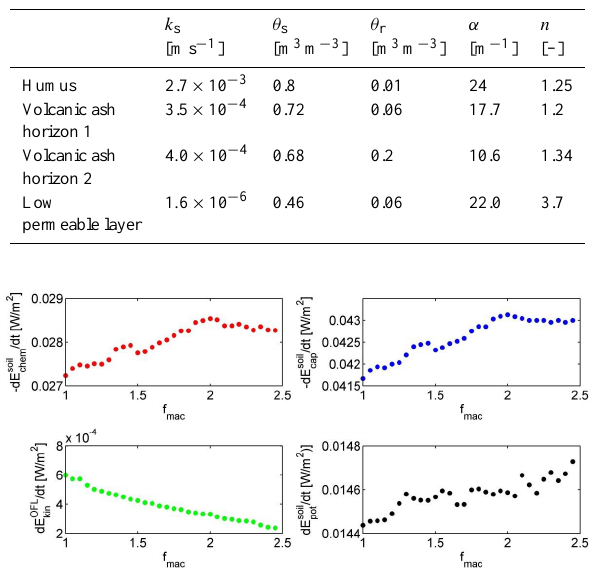
Figure 10: Temporal averaged change rates in free energy during rainfall driven conditions for Fig. 10. Temporally averaged change rates in free energy during numerical experiment 2 in the Weiherbach plotted against the macroporosity factor: total free rainfall-driven conditions for numerical experiment 2 in the Wei- energy of soil water (a) (as defined in Eq. 8), capillary binding energy (b), kinetic energy herbach plotted against the macroporosity factor: total free energy of soil water (a) (as defined in Eq. 8), capillary binding energy (b) , export by surface runoff (panel c) and potential energy (panel d). Note that panel a and b kinetic energy export by surface runoff (c) and potential energy (d) . show the minus one times the change rate to better visualize the maxima located at f mac values Note that panels (a) and (b) show the minus one times the change of 1.45 and 2.05. rate to better visualize the maxima located at f mac values of 1.45 and